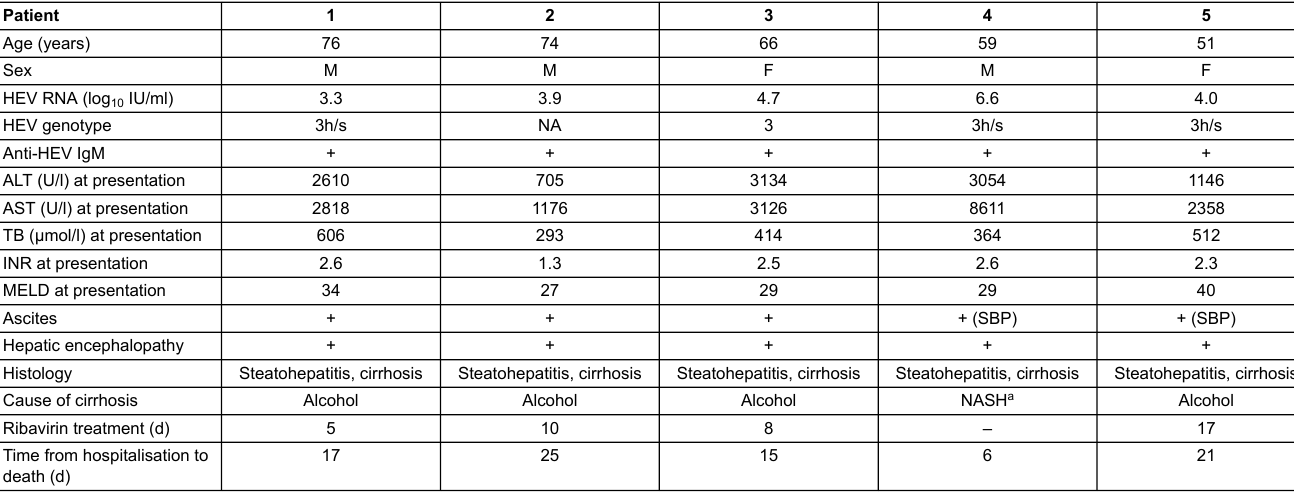
Table 1: Clinical characteristics and laboratory features of patients with HEV-related ACLF and death. Patient